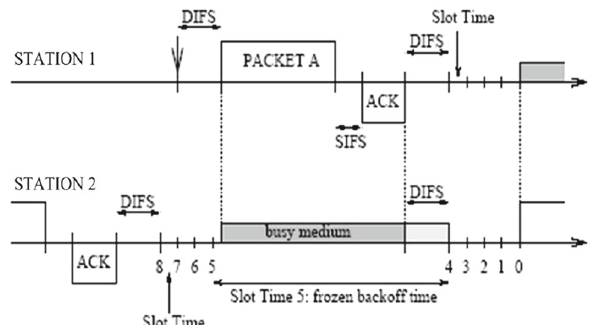
Fig. 1 Illustration of basic access and back-off mechanism of DCF